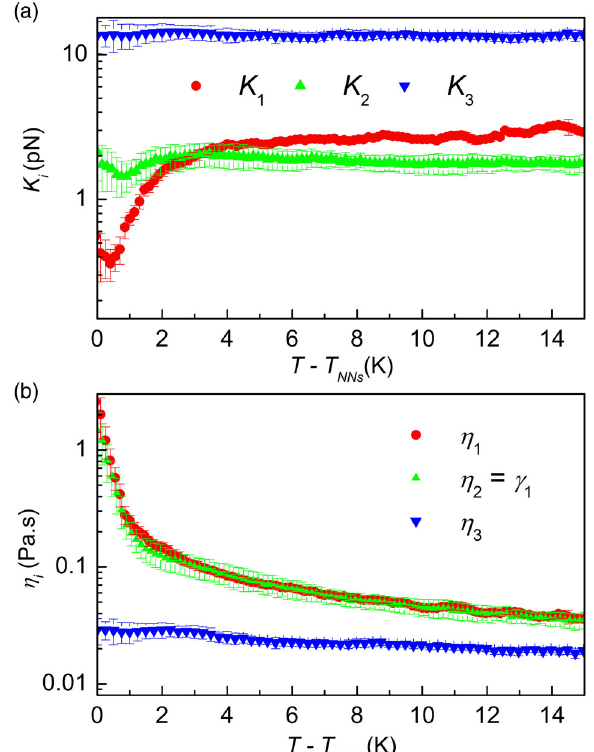
= η , which are FIG. 7. Temperature dependence of (a) elastic constants K i i and (b) viscosities η in the N phase close to the N - N i transition. The most interesting is the behavior of the splay elastic constant, which goes toward zero when approaching the phase transition. The cooling rate is 0 . 03 K =